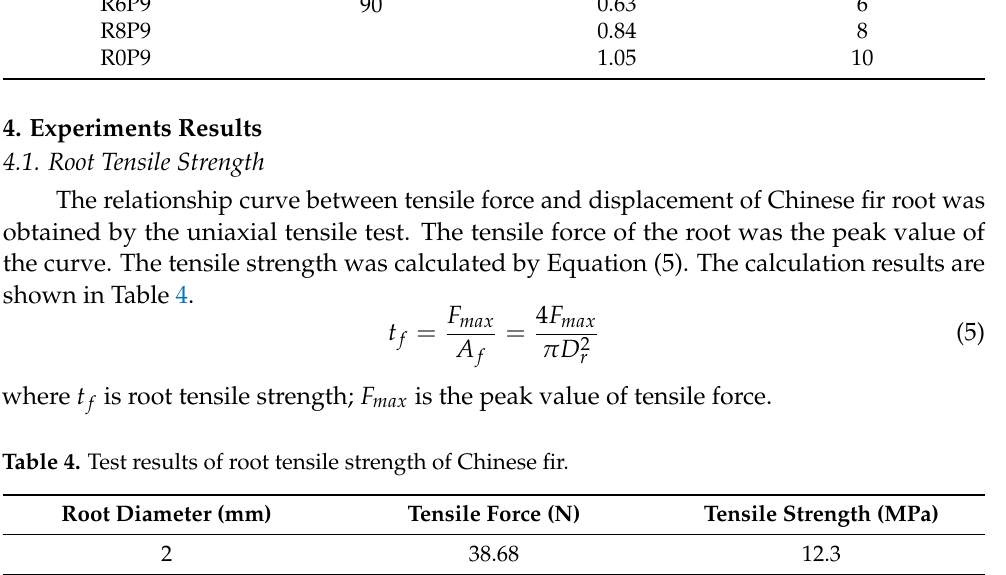
Figure 13. Preparation of root-permeated soil sample with δ of 45 ◦ (RAR0.21% as an example).